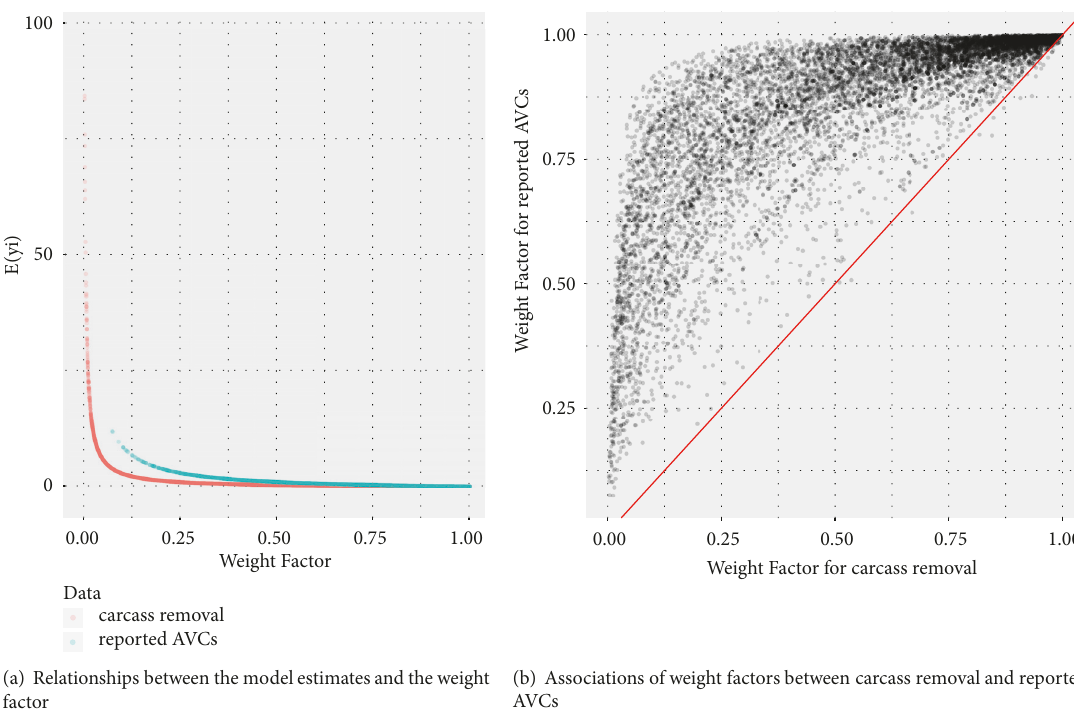
Figure 2: Weight factors produced by NB model.